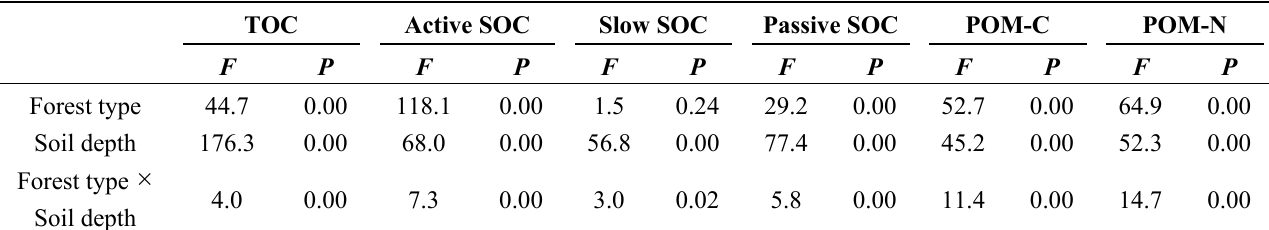
Table 2. Significance of the effects of forest type, soil depths, and forest type × soil depths on the various soil organic carbon (C) fractions in the two-way analysis of variance (ANOVA). TOC Active SOC Slow SOC Passive SOC POM-C POM-N F P F P F P F F P Forest type 44.7 0.00 118.1 0.00 0.00 Soil depth 176.3 0.00 68.0 56.8 45.2 0.00 52.3 0.00 Forest type × 4.0 0.00 7.3 0.00 0.00 Soil depth